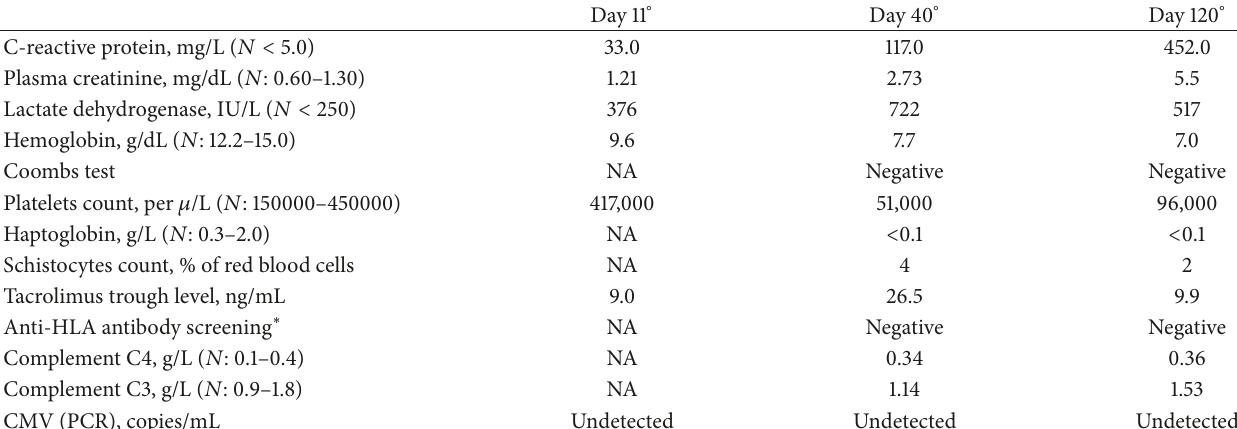
Table 1: Laboratory findings.